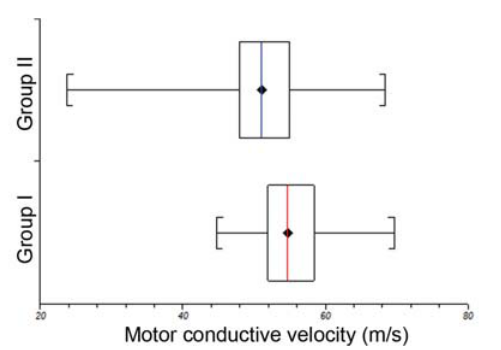
FIGURE 3. Motor conductive velocity. Median MCV value for Group I was 54.75 m/s, and for the Group II 51.05 m/s. The differences were statistically signi fi cant (p< 0.001).